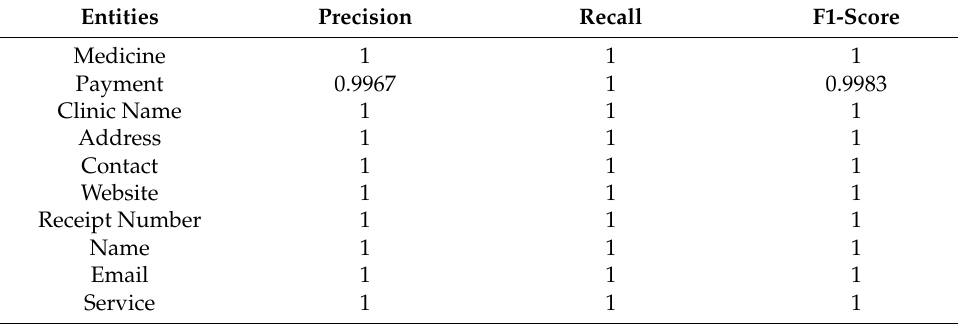
Table 4. NER model performance on entities